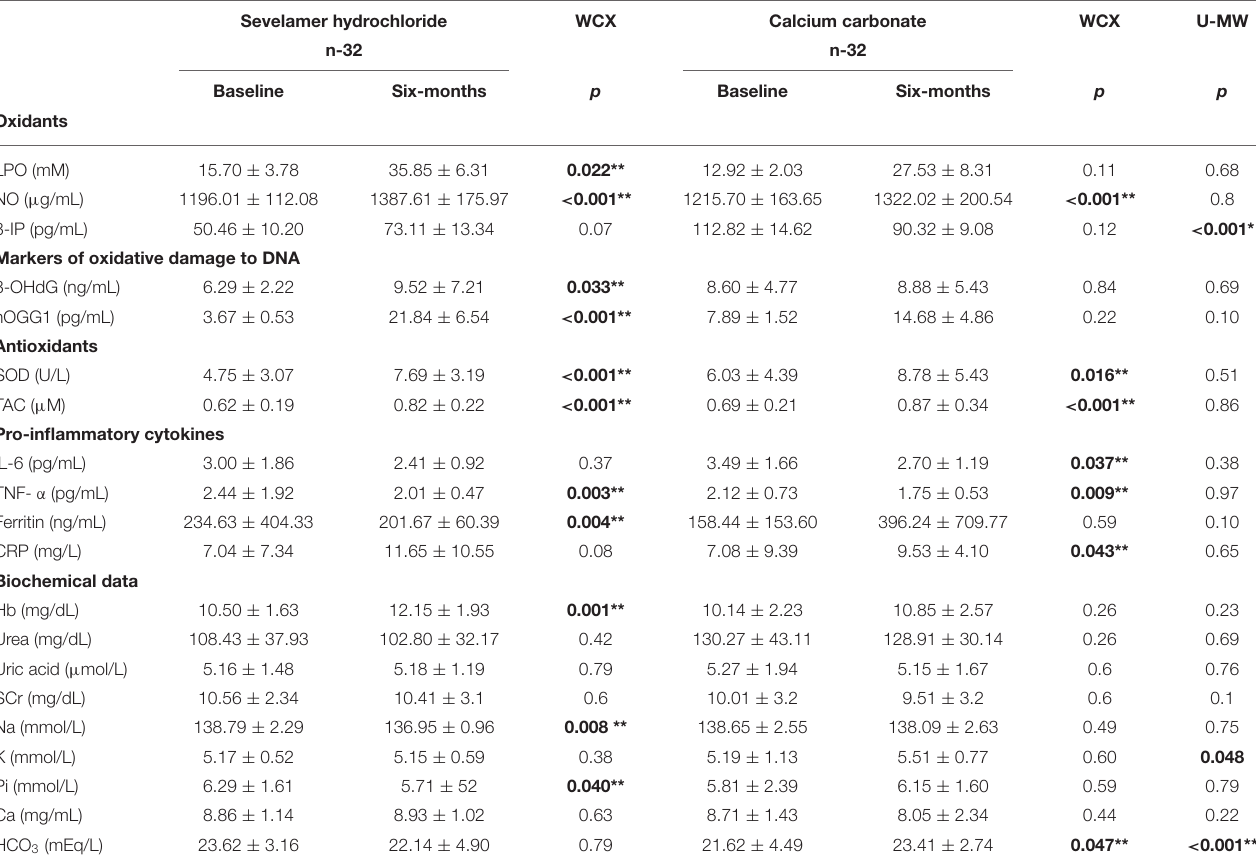
TABLE 3 | Sevelamer hydrochloride or Calcium carbonate